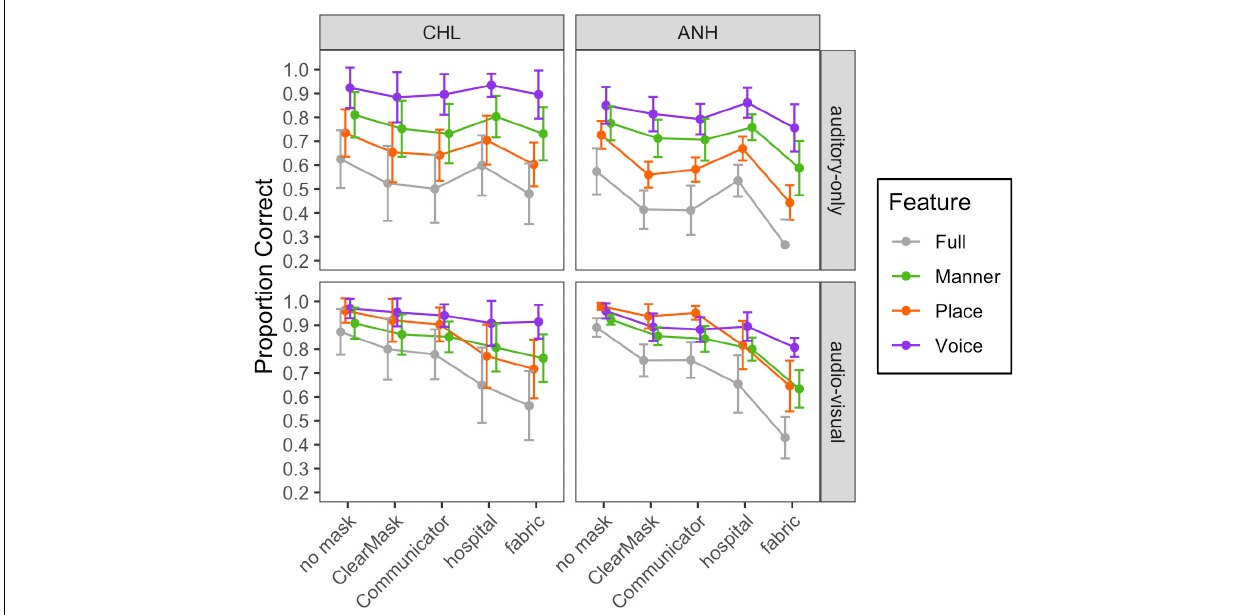
FIGURE 6 | Mean and standard deviation of scores for each of the auditory-only and audiovisual stimulus conditions, plotted separately for each group and modality, as indicated at the top and right of each panel, respectively. Mask type is indicated on the horizontal axis, and articulatory feature is indicated with color, as defined in the